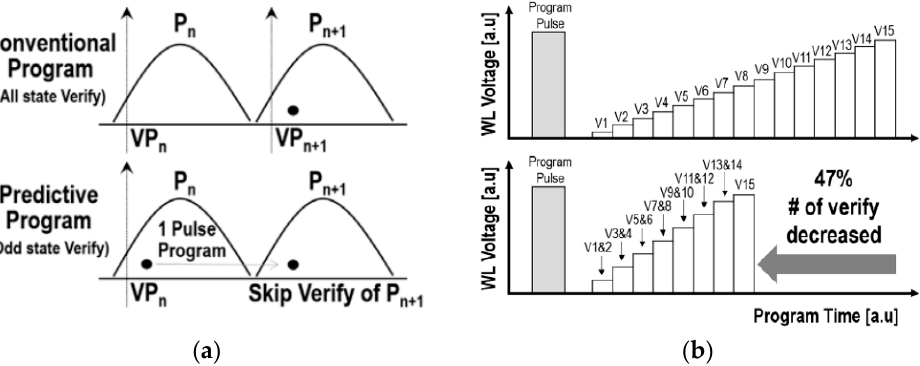
Figure 4. ( a ) Proposed program scheme using predictive verifying concept. Reprinted/adapted with permission from Ref. [36], 2020, IEEE. ( b ) The number of verifies is decreased by 47% using the predictive program scheme. Reprinted/adapted with permission from Ref. [36], 2020, IEEE.